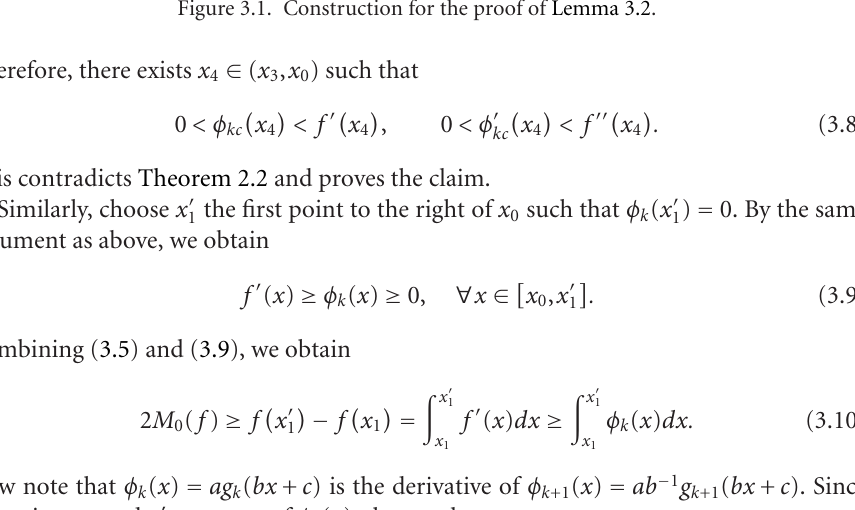
Figure 3.1. Construction for the proof of Lemma